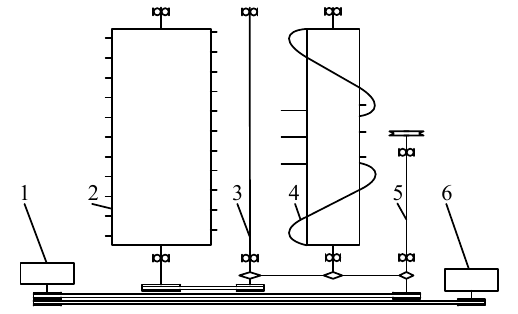
Figure 10. Schematic diagram of the DCH transmission system. 1. Wobble box of the lower cutterbars; 2. Reel; 3. Intermediate shaft of the reel; 4. Screw conveyor; 5. Driving shaft; 6. Wobble box of the upper cutterbars. Table 3. Transmission ratio of the DCH.